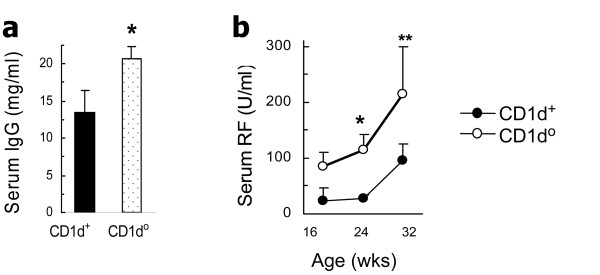
Serum total immunoglobulin G (IgG) and rheumatoid factor (RF) are increased in CD1d-deficient (CD1d°) BWF1 mice. CD1d° BWF1 mice and control littermates (CD1d+/+ or CD1d+/-, designated as CD1d+) were bled and serum samples tested for total IgG and RF levels. (a) Eight-month-old CD1d+ (n = 7) and CD1d° (n = 13) mice (*P = 0.04). (b) CD1d+ (n = 8) and CD1d° (n = 15) mice (*P <0.01 and **P = 0.03 to 0.06). The negative control mean ± SD value in six normal BALB/c mice was 28.2 ± 8.6 U/ml for RF. Results are expressed as the mean ± standard error of the values.